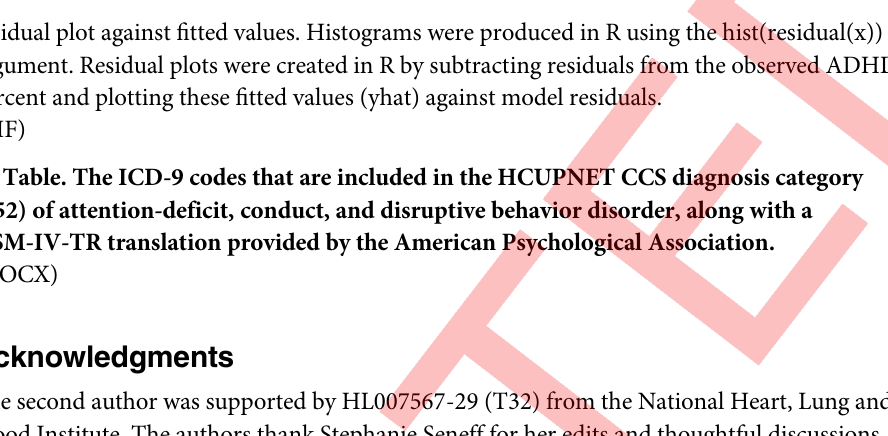
residual plot against fi tted values. Histograms were produced in R using the hist(residual(x)) argument. Residual plots were created in R by subtracting residuals from the observed ADHD percent and plotting these fi tted values (yhat) against model residuals. S1 Table. The ICD-9 codes that are included in the HCUPNET CCS diagnosis category (652) of attention-deficit, conduct, and disruptive behavior disorder, along with a DSM-IV-TR translation provided by the American Psychological